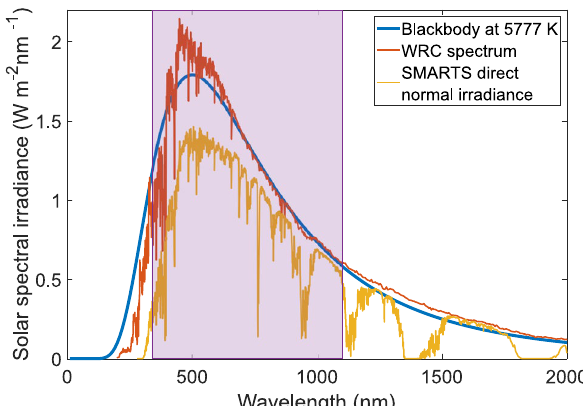
Figure 1. Solar spectral irradiance. The composite solar spectral irradiance curve (orange) compiled by Wehrli 44 and the Physikalisch-Meteorologisches Observatorium Davos / World Radiation Center (WRC) is often cited as the standard extraterrestrial spectral irradiance. This curve is well approximated by a black-body at 5777 K at 1 AU (blue). The Simple Model of the Atmospheric Radiative Transfer of Sunshine (SMARTS) by Gueymard 45 and hosted by the National Renewable Energy Laboratory (NREL), is used to model solar spectral irradiance on Earth’s surface. The yellow curve shows the Direct Normal Irradiance in Edinburgh, Scotland in May 2020 using SMARTS version 2.9.5. Compared to the extraterrestrial curve, the SMARTS irradiance shows noticeable atmospheric filtering, including the characteristic absorption bands of O 2 , H 2 O , and CO 2 . The purple window represents the 340–1100 nm spectral responsivity range for the silicon photodetector used to measure �τ Sun in this